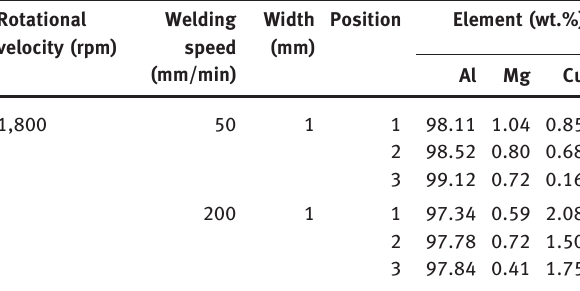
Table 1: Elemental analysis results of the interface for VCFSW joints. Rotational velocity (rpm)